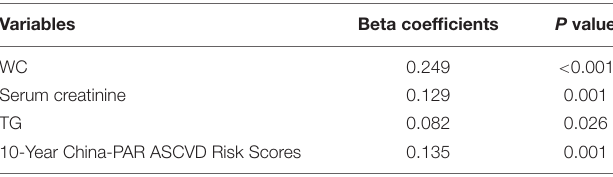
TABLE 4 | Association of 10-year China-PAR ASCVD risk scores with serum uric acid. Variables Beta